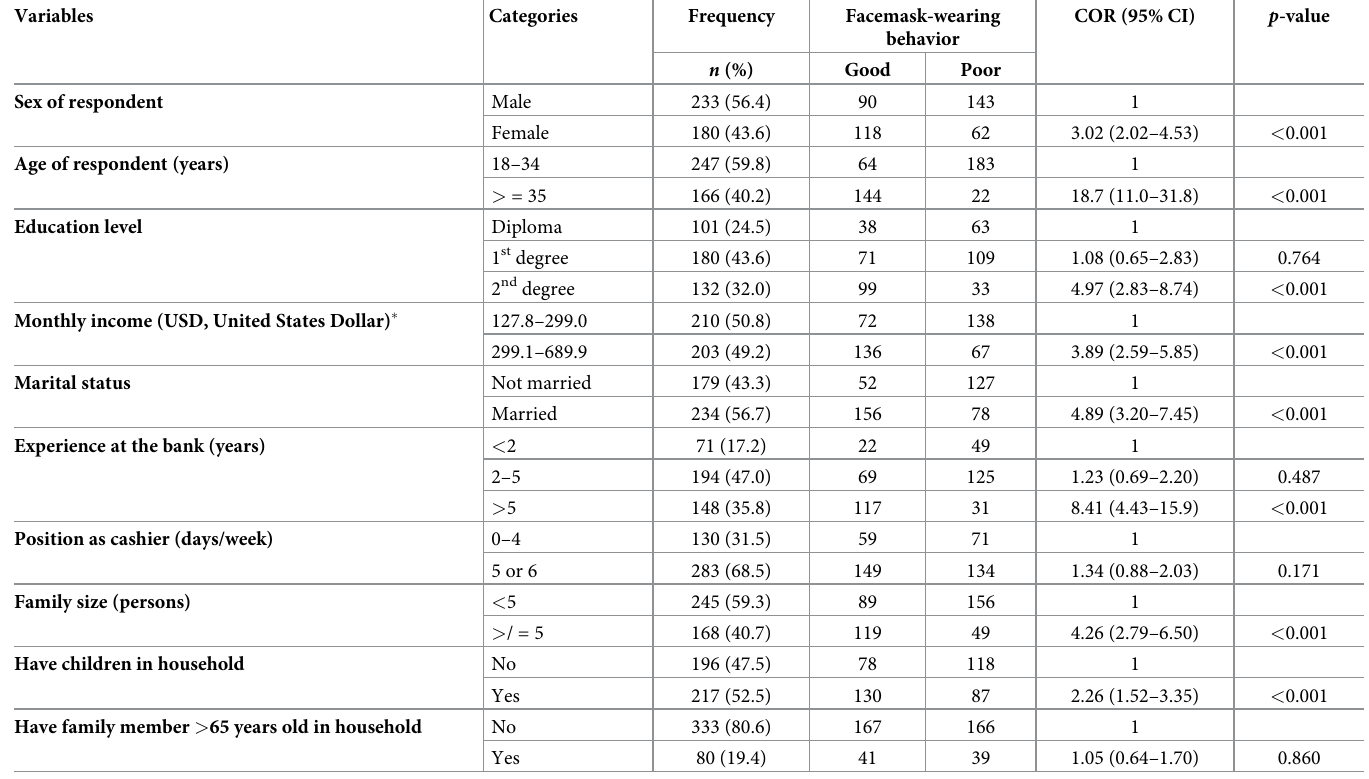
Table 1. Socio-demographic and economic factors and bivariable analysis with facemask-wearing behaviors among bank workers in Dessie City, Ethiopia, January 2021.